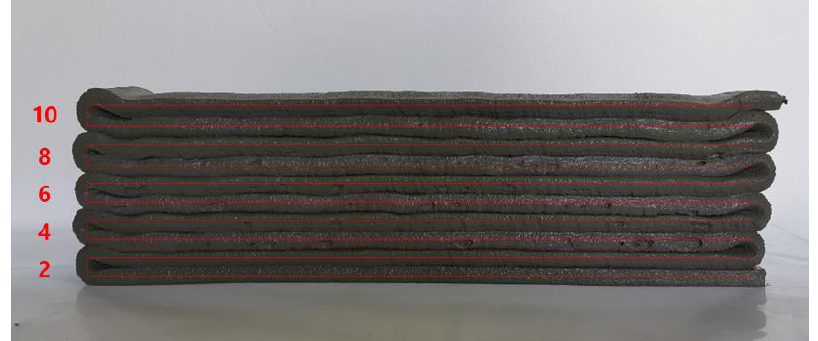
Figure 6. Extrudability test result with the number of printed layers.